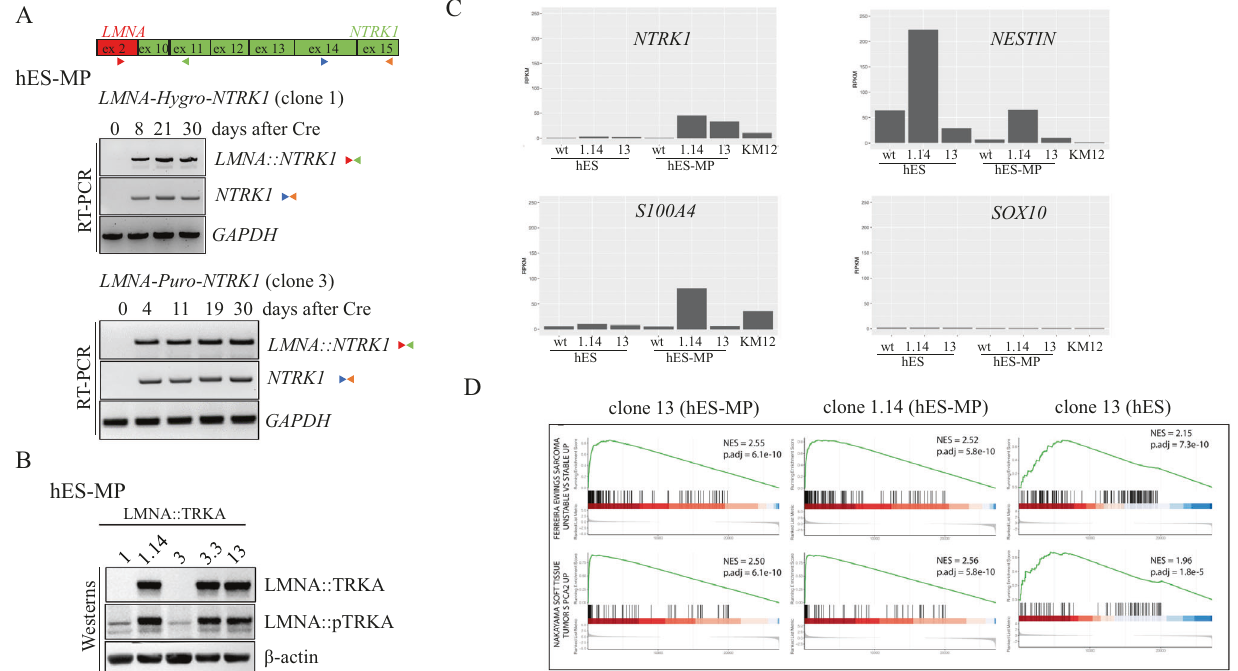
Fig. 2 Expression of LMNA::NTRK1 fusion in human mesenchymal progenitors (hES-MP). A Diagram of LMNA::NTRK1 transcript with primers position for RT-PCR. Time course (days) experiment for LMNA::NTRK1 fusion and NTRK1 expression in hES-MP (clones 1 and 3) after Cre expression. B Western blot showing LMNA::TRKA product and phosphorylation of TRKA in hES-MP cells expressing the fusion transcript. C Histogram plot from RNAseq analysis showing NTRK1, NESTIN, S100A and SOX10 RNA levels in hES and hES-MP expressing the LMNA::NTRK1 fusion compared to wild-type isogenic cell line and colorectal cancer cell line KM12 expressing the TPM3::NTRK1 fusion. D GSEA analysis for cell lines expressing the LMNA::NTRK1 fusion (clones 13 and 1.14 (hES-MP) and 13 (hES)). GSEA shows an enrichment of pathways involved in Ewing sarcoma and soft tissue [17]. The ETV6::NTRK3 fusion results from a balanced t(12;15) (p13;q25) translocation, encompassing the entire kinase domain of TRKC expressed by exons 15 – 18 of NTRK3 , with the ATP-binding pocket on exon 16 and the activation loop on exon 17 (Figs. 3A and S2). Employing a similar methodology used to model the desmoplastic small round cell tumor EWSR1::WT1 fusion [8], we aimed to fuse ETV6 exons 1 – 5 to NTRK3 exons 15-19 in hES cells (Fig. 3B). Brie fl y, a donor template with homology arms was transfected into hES cells and integrated by HDR at the participating loci. The donor template carries a puromycin selectable marker that is expressed under the control of a PGK promoter and can be excised by Cre recombinase. From the 56 puromycin resistant clones, the PCR analysis showed one clone harboring the translocation (clone G2), which was con fi rmed by the break-apart FISH analysis (Fig. 3C). The reciprocal translocation (der 12) was not detected in this clone. Cells were then differentiated to hES-MP progenitors, and the fusion transcript levels were monitored in both cell types, remaining stable for a 30- day period (Fig. 3D). Of note, the fusion transcript was detectable in both cell types before Cre expression at consistently lower levels compared to post-Cre cells, likely due to a partial splicing to delete the selectable marker [8]. After Cre expression, hES clones that had removed puromycin marker were isolated (clone G2-6) and differentiated to hES-MP. Immunohistochemistry with pan- TRK antibodies con fi rmed the nuclear localization of the ETV6::TRKC fusion protein observed in tumor samples [14, 15] (Fig. S3C). Comparison of the fusion transcript levels between the two cellular backgrounds (hES and hES-MP) showed a higher level of ETV6::NTRK3 fusion in mesenchymal progenitors (Fig. S3D), as for LMNA::NTRK1 . The induction of the ETV6::TRKC protein and the phosphorylation of the TRKC portion were detected by western